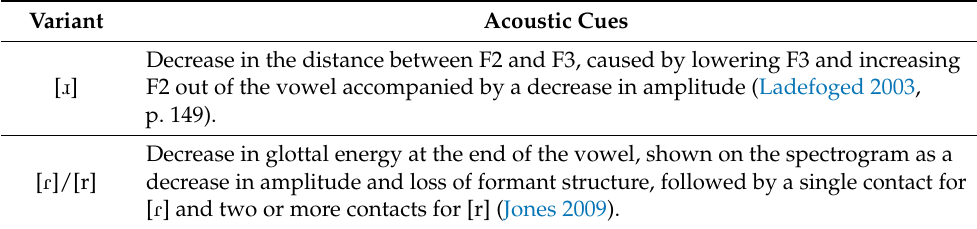
Table 3. Acoustic cues used for the identification of /r/